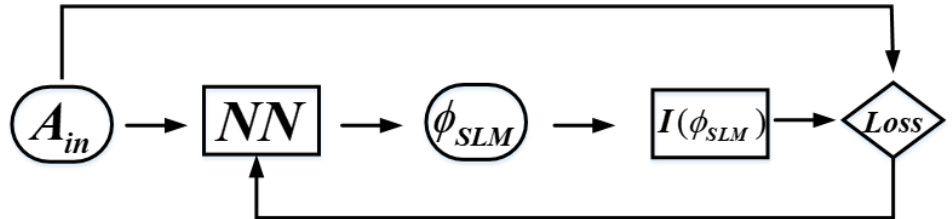
Figure 2. Network training logic.